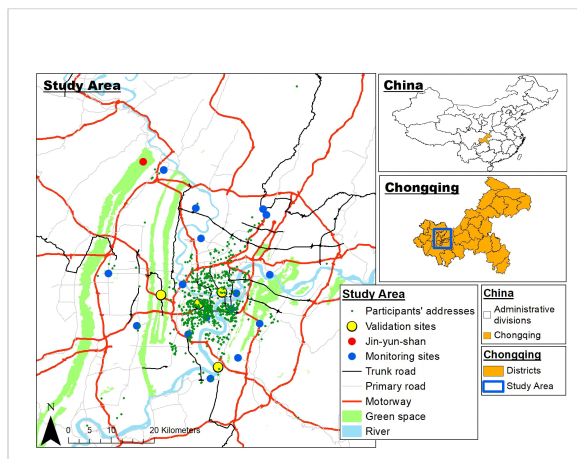
FIGURE 2 Map of Chongqing showing the location of the monitoring sites and participants ’ residential